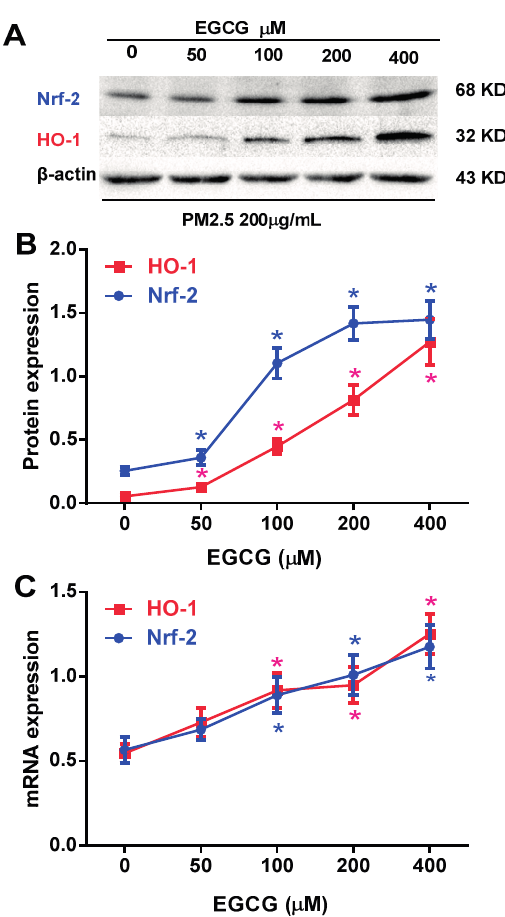
Figure 5. EGCG increased Nrf2 and HO-1 expression in PM 2.5 -treated HUVECs. ( A ) Representative images of Nrf2 and HO-1 protein expression in HUVECs incubated with 0–400 μ M EGCG + 200 μ g/mL PM 2.5 for 24 h. EGCG was added to the medium 30